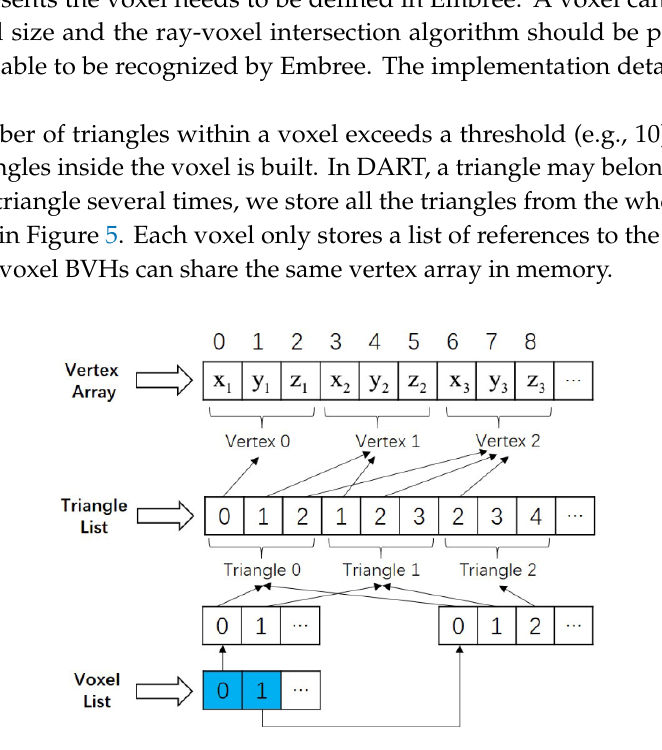
Figure 5. Triangle management in hybrid scene structuring scheme.